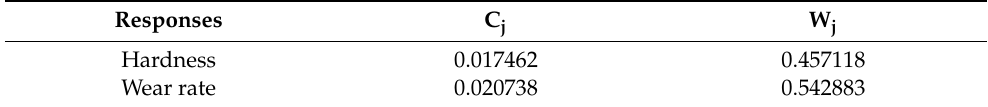
Table 8. Weight fractions of different